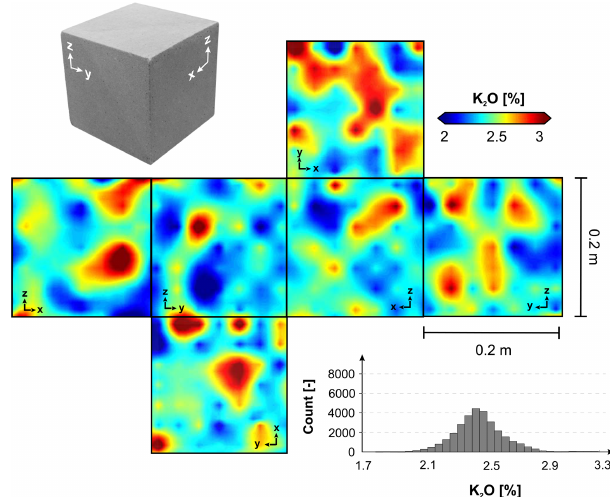
Figure 12. Spatial distribution of the mass fraction of K 2 O modeled with a simple kriging interpolation. The pattern is decoupled from primary sedimentary structures and shows a network-like structure.